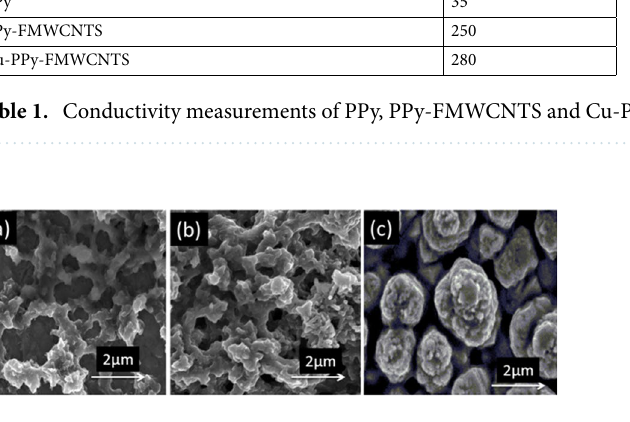
Figure 2. SEM images of ( a ) PPy, ( b ) PPy-FMWCNTS, ( c )